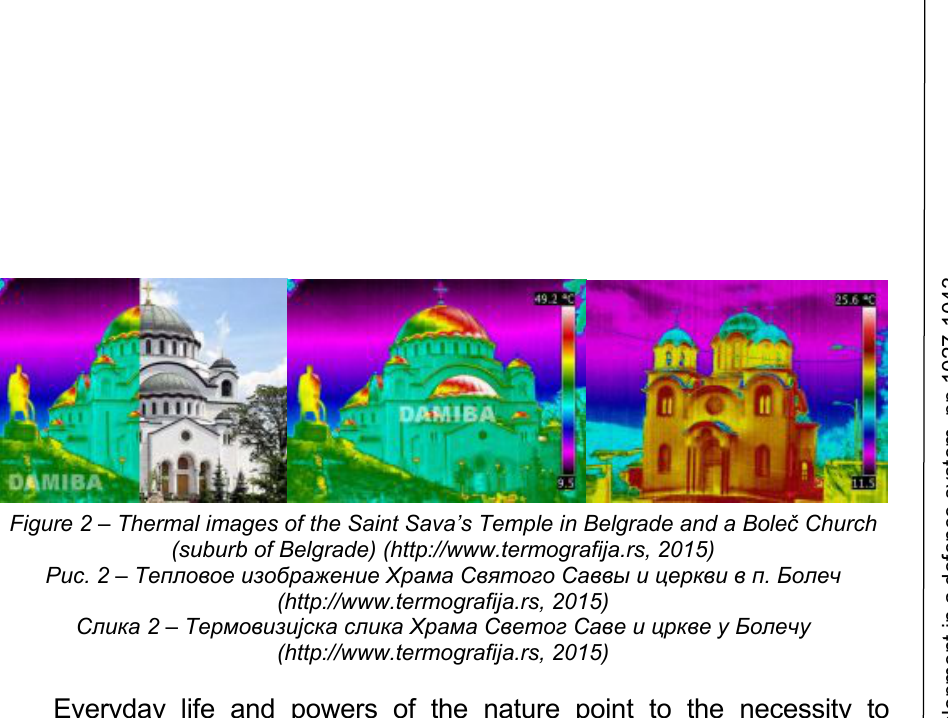
(Figure 3). In order to prevent this, their cleaning has began ( http://studiob.rs, 2015)."